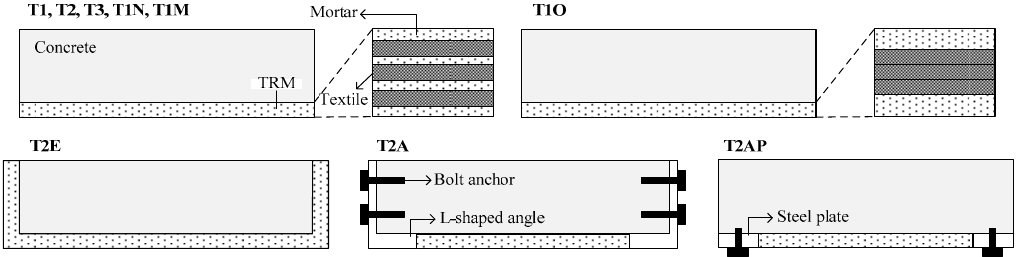
Figure 4. Schematic of TRM specimens.